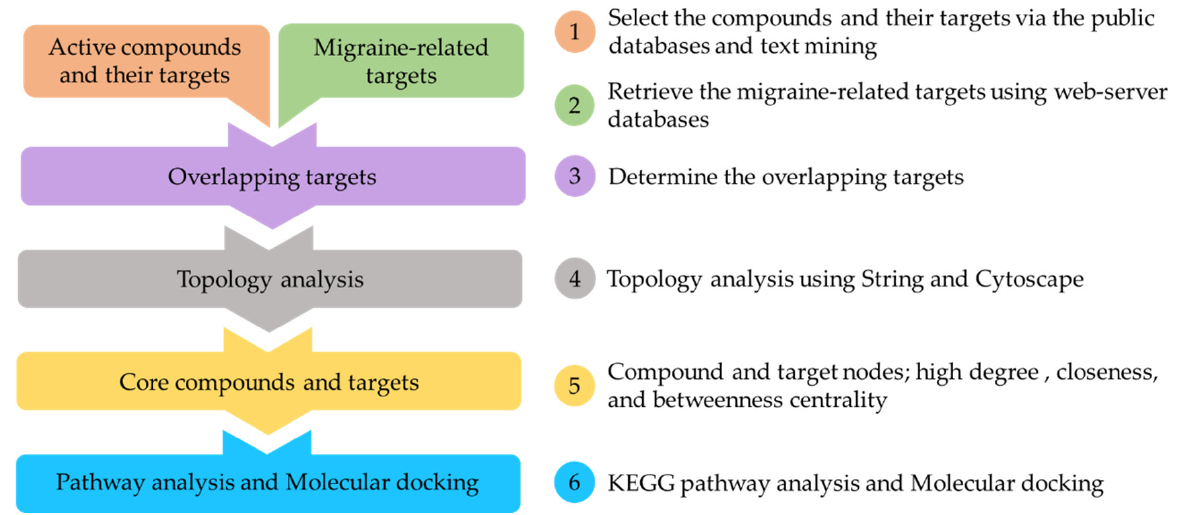
Figure 9. Workflow of network pharmacology analysis of ALHP.